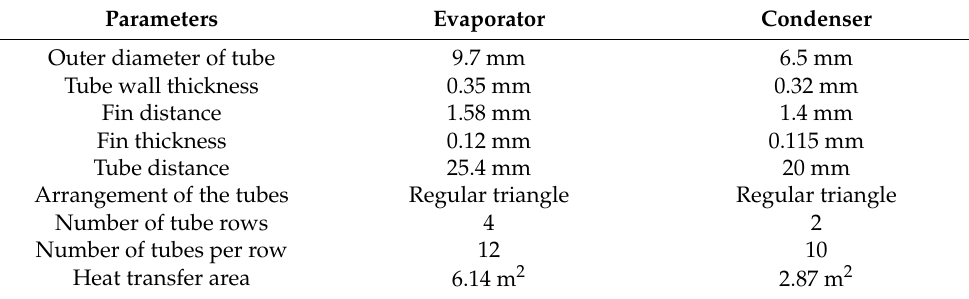
Table 3. Structural parameters of separated heat pipe.